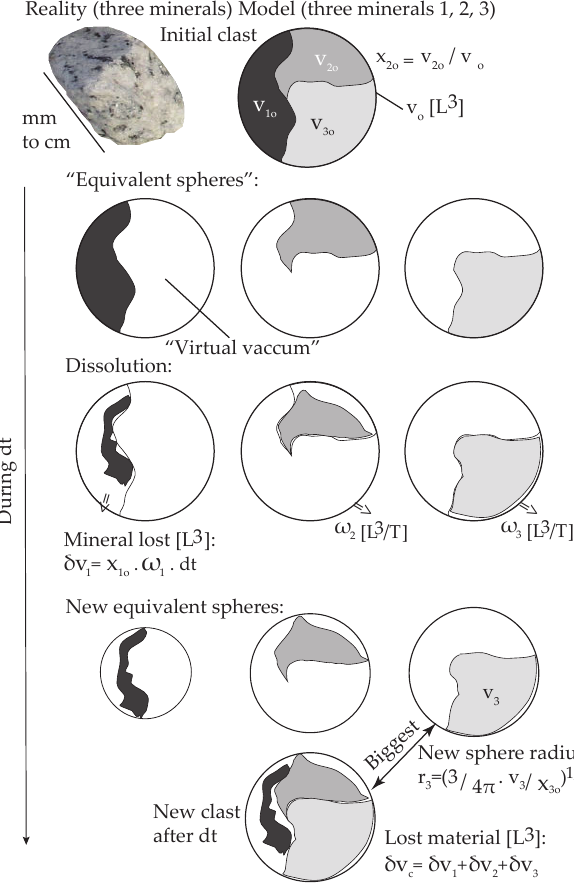
Figure 1. The dissolution model for a clast made up of three dif- ferent mineral types. The sequence from top to bottom illustrates the mineral dissolution and the resulting clast size decrease during a time